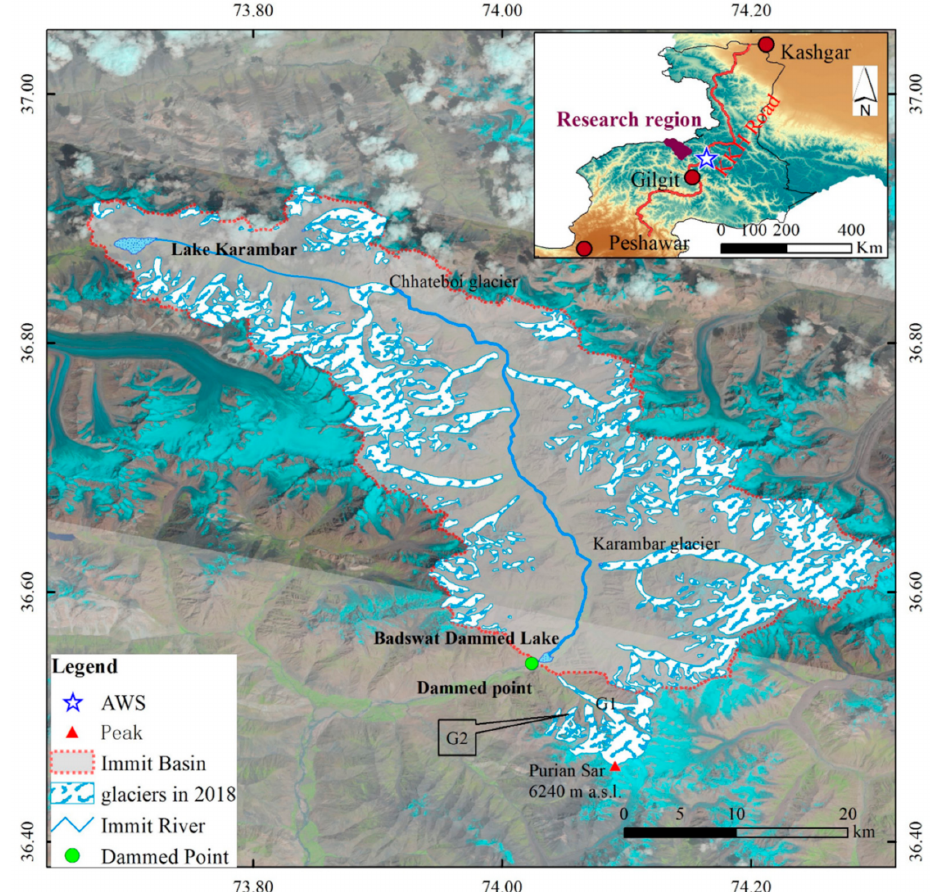
Figure 1. The location of the Badswat village in Pakistan. The dammed point is marked in green. The automatic weather station (AWS) is sited in the southeast of Badswat. The glacial debris flow was initiated from G2 (Background images: Landsat 8 OLI Path: 150, Row: 34–35, acquired on 11 August